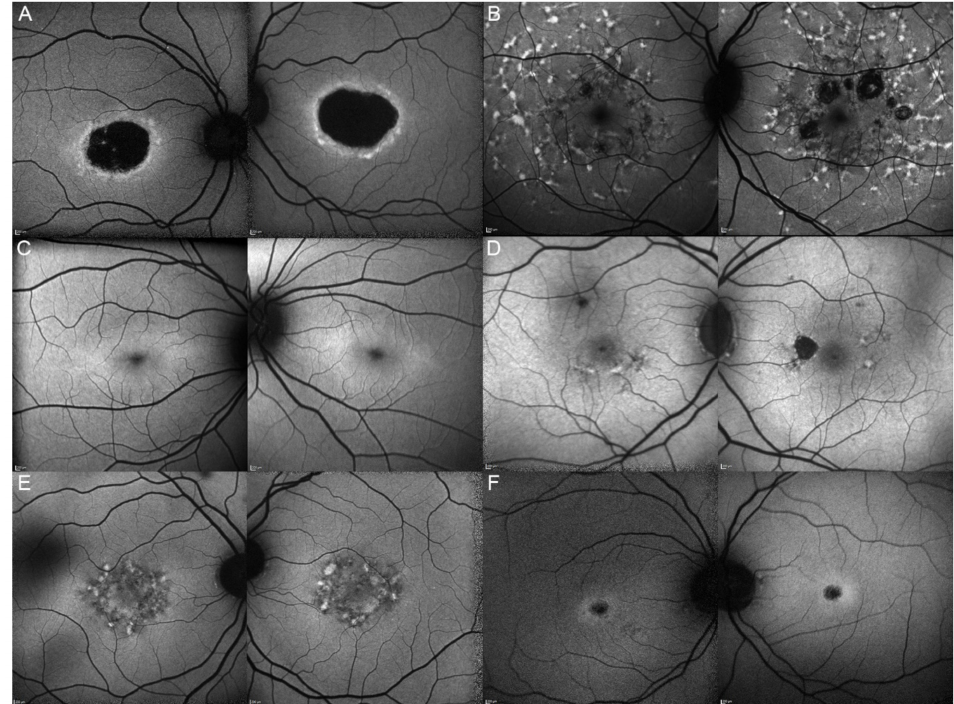
Figure 7. Fundus autofluorescence imaging of patients harboring the pathogenic c.810C>G p.(Tyr270*) ELOVL4 variant. Patient 12/II.2 ( A ), patient 13/II.1 ( B ), patient 13/III.2 ( C ), patient 13/I.1 ( D ), patient 14/II.4 ( E ), and patient 15/II.3 ( F ). For each patient, the left panel shows the right eye, and the right panel the left one. The FAF findings are described in detail in Table